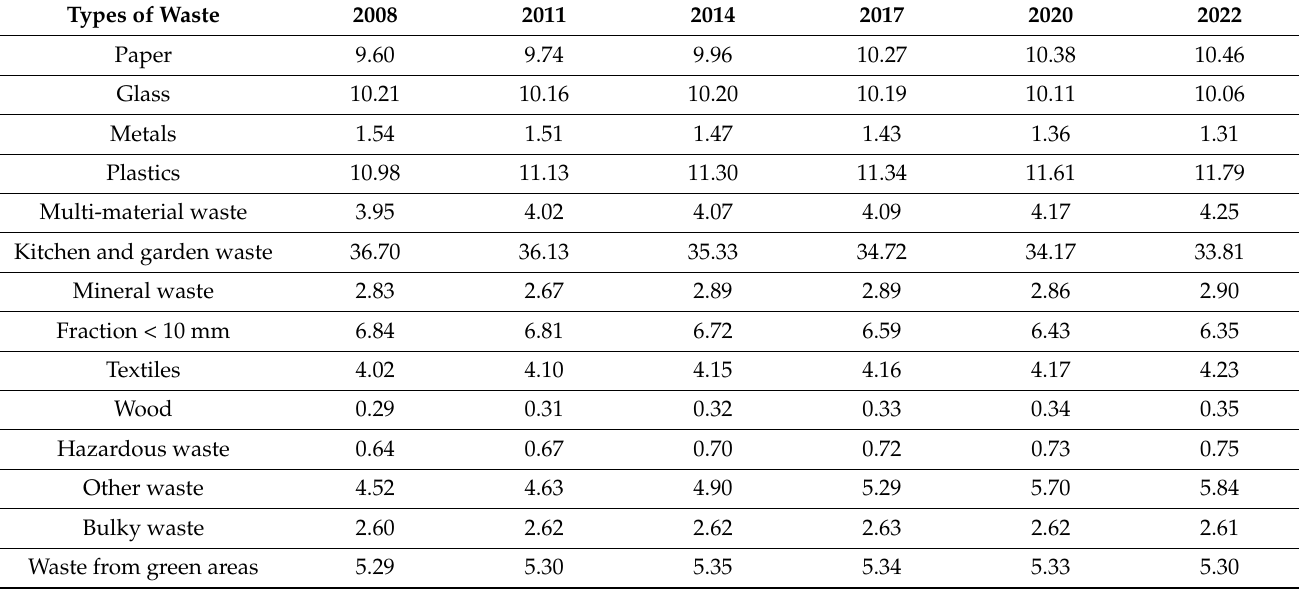
Table 3. Projected changes in the morphological composition of municipal waste from small towns (%)